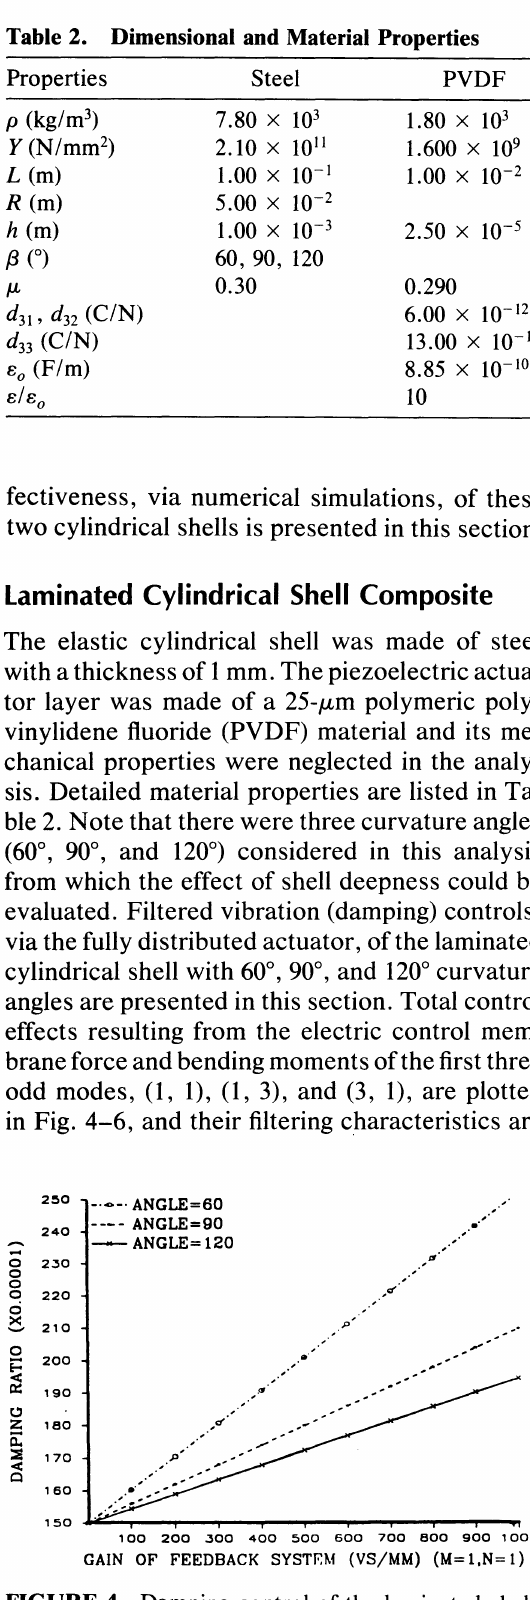
FIGURE 4 Damping control of the laminated